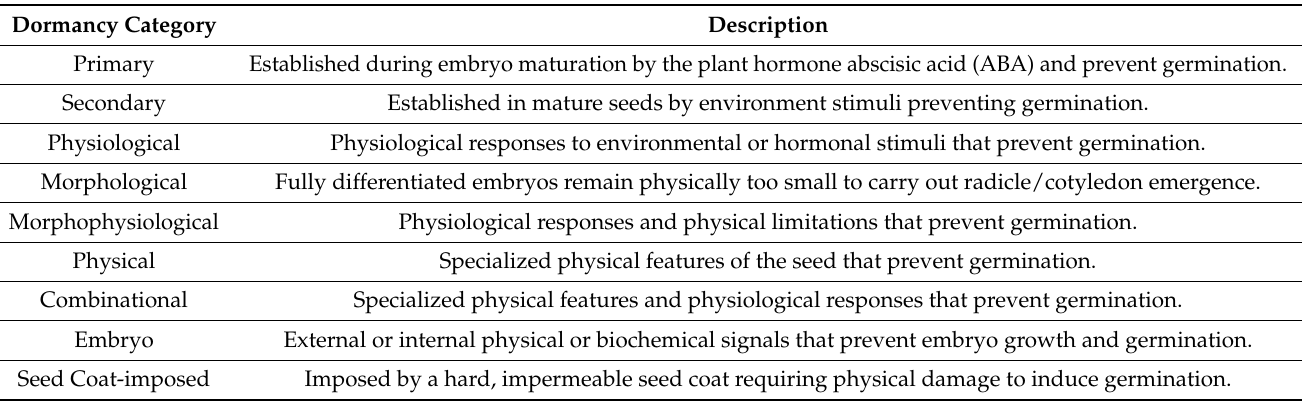
Table 1. A summary of recognized seed dormancy categories